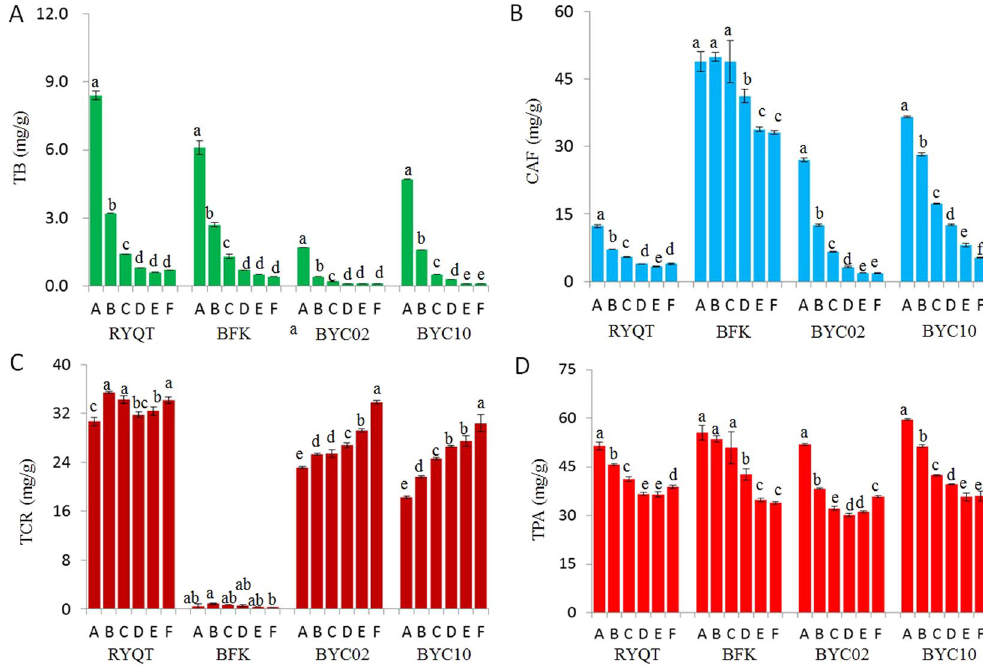
Figure 5. Purine alkaloid contents in different parts of ‘six and a bud’ tea shoots. ( A ) theobromine (TB), ( B ) caffeine (CAF), ( C ) theacrine (TCR), ( D ) total purine alkaloids (TPA). RYQT, ‘Ruyuan Qunti’; BFK, ‘Benifuuki’; BYC, ‘Baiyacha’. A. bud and first leaf; B. second leaf; C. third leaf; D. fourth leaf; E. fifth leaf; F. sixth leaf. The data are presented as the mean ± standard error of three independent analyses. Different letters above columns denote the existence of significant difference (p < 0.05).